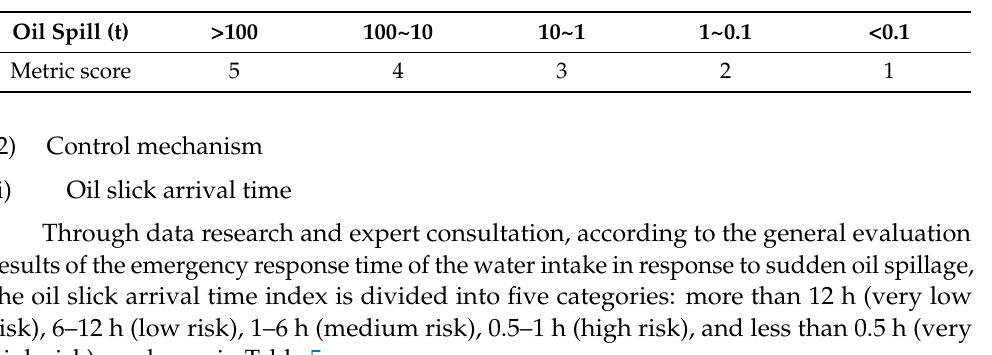
Table 4. Oil spill index scores.